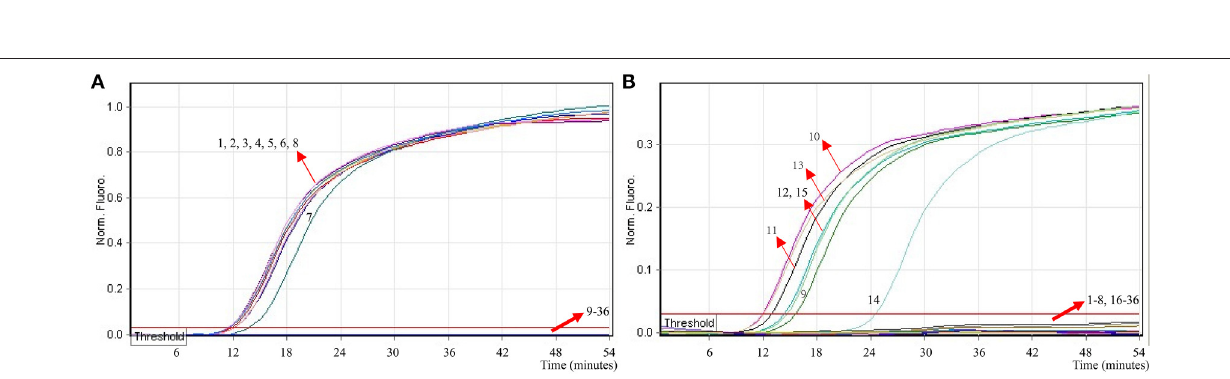
FIGURE 8 | The specificity of multiplex MERT-LMAP detection for different strains. The multiplex MERT-LAMP reactions were conducted using different genomic DNA templates and were analyzed by means of real-time format. (A,B) were simultaneously yielded from Cy5 and Hex channels. Signals 1–8, Shigella flexneri strains of serovar 1d (ICDC-NPS001), 4a (ICDC-NPS002), 5a (ICDC-NPS003), 2b (ICDC-NPS004), 1b (ICDC-NPS005), Shigella boydii , Shigella sonneri and Shigella dysenteriae ; signals 9–13, Salmonella Choleraesuis (ICDC-NPSa001), Salmonella Dublin (ICDC-NPSa002), Salmonella Enteritidis (ICDC-NPSa003), Salmonella Typhimurium (ICDC-NPSa004), Salmonella Weltevreden (ICDC-NPSa005); signals 14 and 15, two Salmonella strains of unidentified serotype; signals 16–35, Listeria monocytogenes stains of serovar 1/2a (EGD-e), Listeria monocytogenes stains of serovar 4a (ATCC19114), Enteropathogenic E. coli , Enterotoxigenic E. coli , Enteroaggregative E. coli , Enteroaggregative E. coli , Enteroinvasive E. coli , Enterohemorrhagic E. coli , Plesiomonas shigelloides , Enterobacter cloacae , Enterococcus faecalis , Yersinia enterocolitica , Bntorobater sakazakii , Vibrio cholerae , Vibrio parahaemolyticus , Vibrio vulnificus , Staphylococcus aureus , Campylobacter jejuni , Pseudomonas aeruginosa, and Bacillus cereus , signal 36, negative